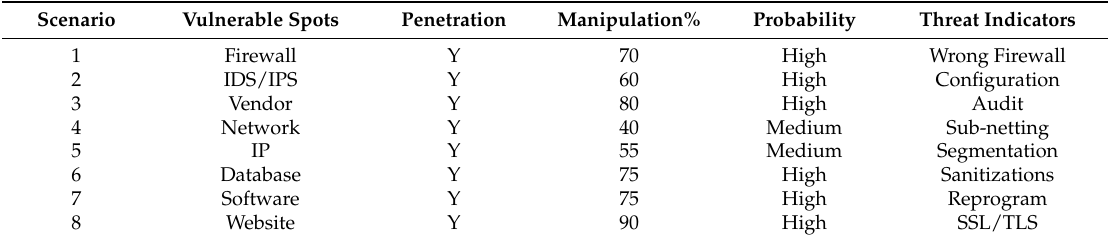
Table 4. Probability and threat